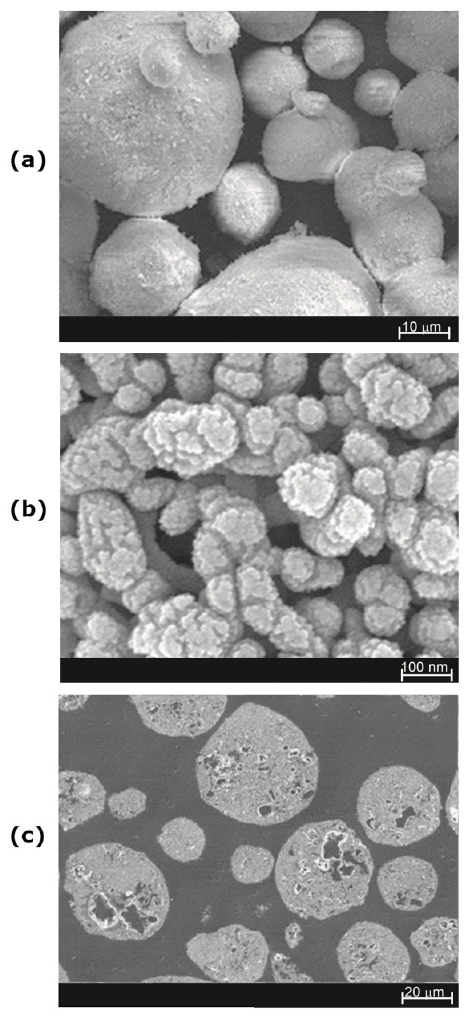
Figure 2. Hydroxyapatite (HA) powder grain morphology, ( a ) powder grain surface morphology, ( b ) powder grains cross-section, ( c ) obtained using JEOL JSM-7100 scanning electron microscope (Tokyo, Japan); ( a ) ×500, ( b ) ×10,000, ( c ) ×1000 magnification. XRD analysis confirmed the presence of only hydroxyapatite in the powder. No other forms of calcium phosphate were observed (Figure 3).